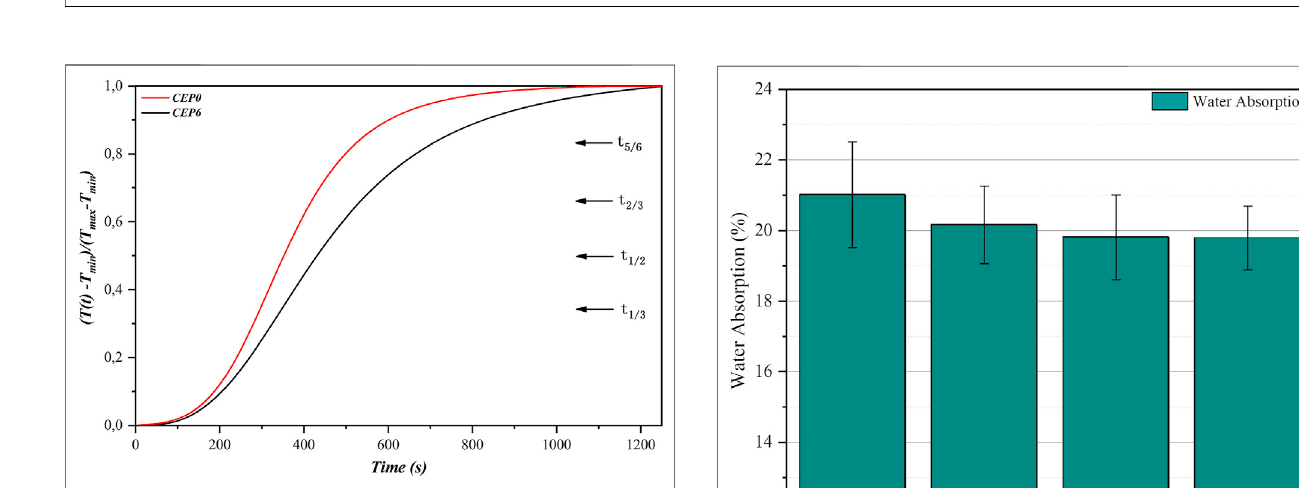
FIGURE 6 | The variation of thermal properties for increasing EPS content.